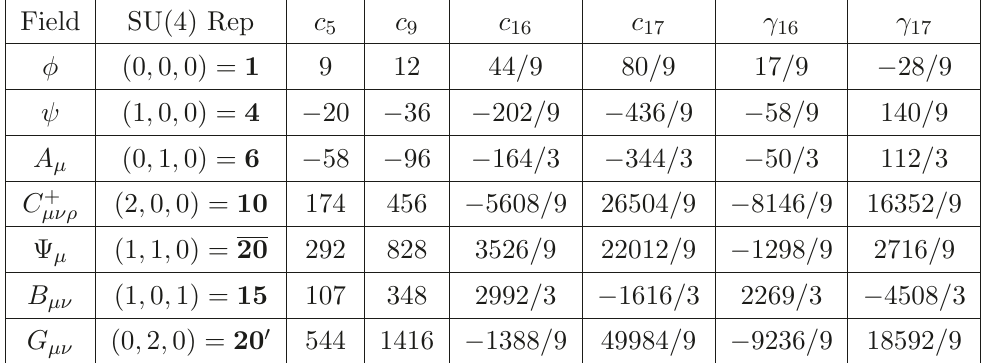
Table 1 . Heat kernel coefficients (4 π ) 3 7! b 6 = c 5 A 5 + c 9 A 9 + c 16 A 16 + c 17 A 17 for fields of spins up to two on a Ricci-flat background. In the last two columns, we tabulate γ 16 and γ 17 ,